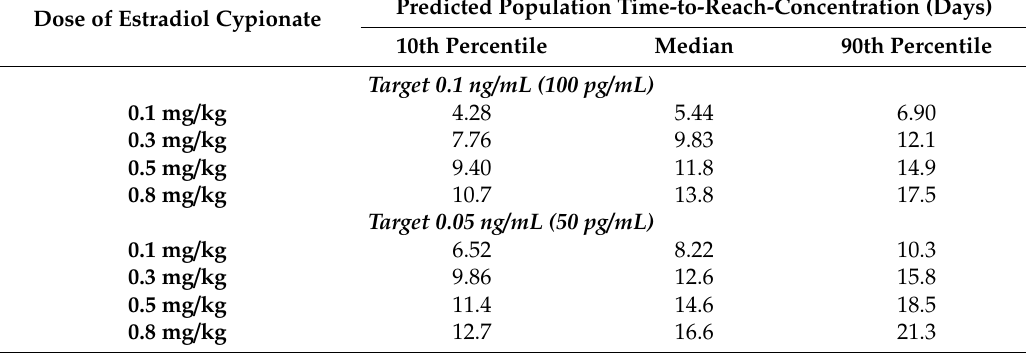
Table 3. Predicted population time-to-reach-concentration (days), for the target estradiol-17 β serum concentrations of 0.1 ng / mL and 0.05 ng / mL, after administration of various doses of intramuscular estradiol cypionate. For each dose, 2000 subjects were simulated from the final pharmaco-statistical model, including residual error in the predicted concentrations. The times to reach the target concentrations were determined from interpolating splines fitted to the empirical percentiles.